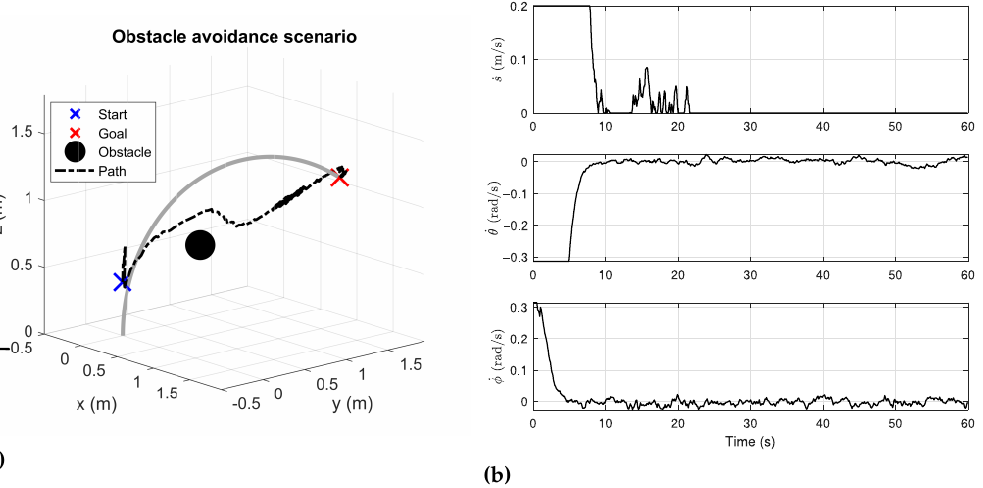
Figure 6. ( a ) The path generated by the proposed NMPC to reach a predefined goal of ( 1,1,1 ) m while avoiding an obstacle with a known location; ( b ) the corresponding actuator inputs generated from the NMPC and applied to the vine-like